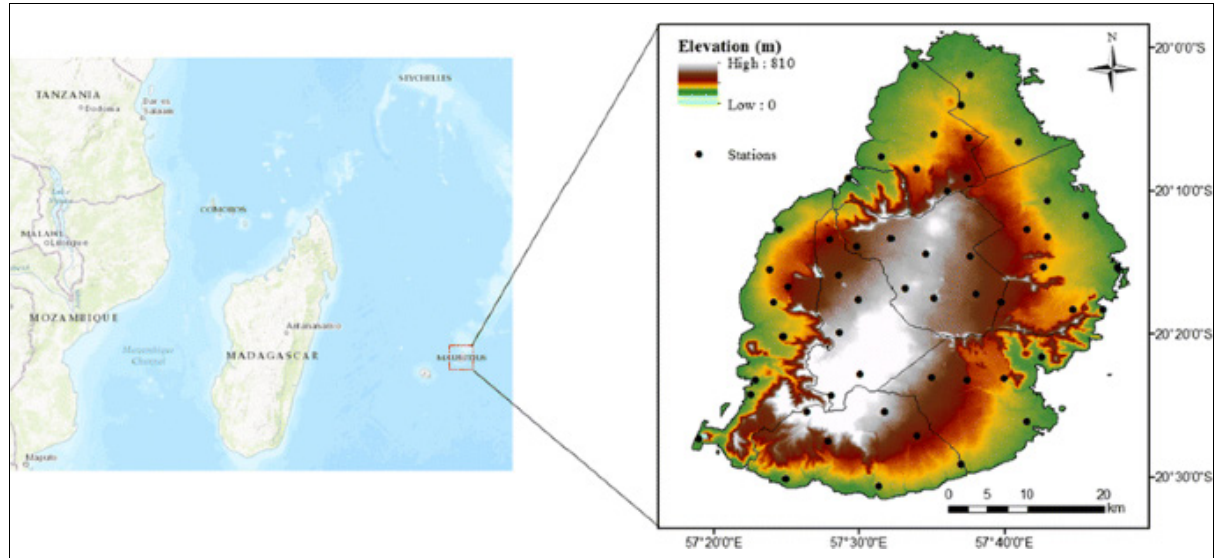
Figure 1: Location of Mauritius in the South West Indian Ocean region (left) and its topography (right). The different weather stations over the island are also shown.